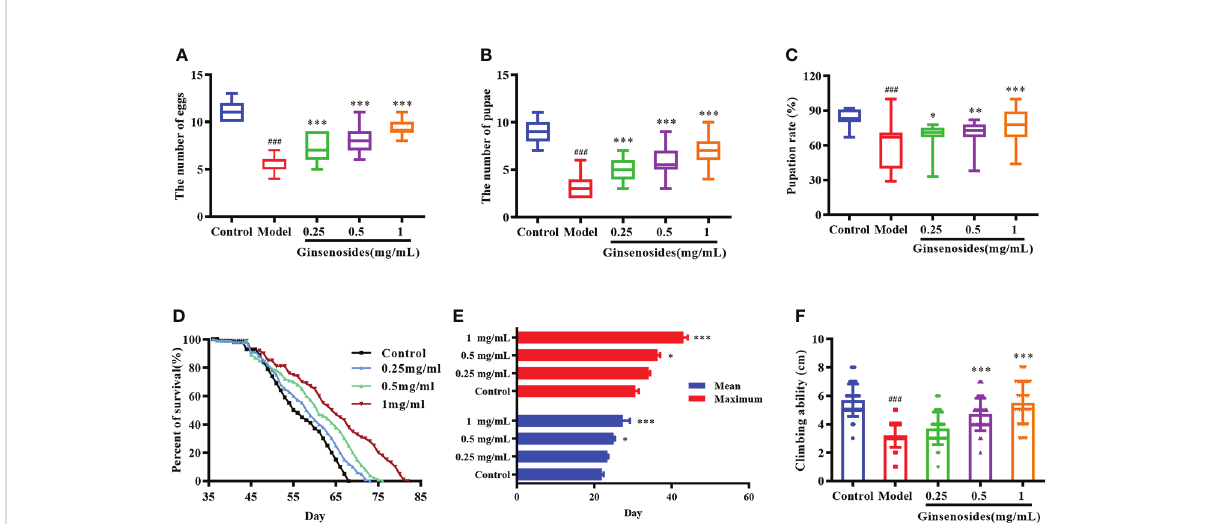
FIGURE 1 Effects of ginsenosides on Drosophila reproduction and aging. (A) The number of eggs; (B) The number of pupae; (C) Pupation rate; (D) Percent of survival; (E) Mean and maximum lifespans; (F) Climbing ability. ### p <0.001 compared with control (7-day-old female Drosophila ); * p <0.05,